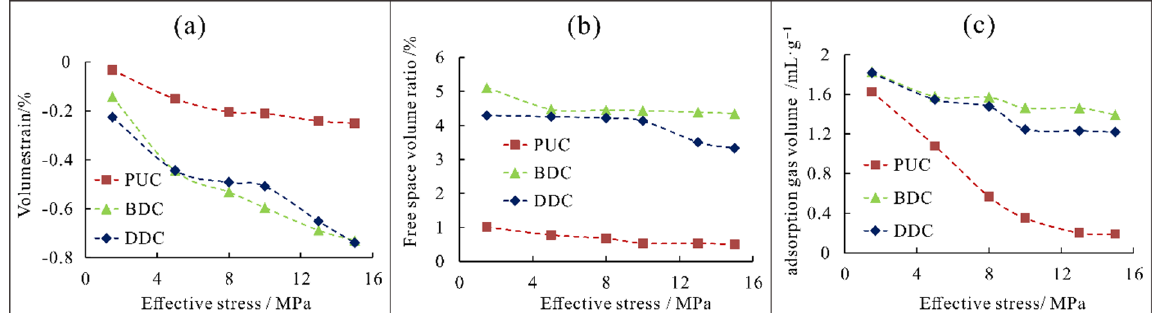
Figure 6. Changes in coal matrix strains, free space volume and adsorption gas volume under effective stresses: ( a ) is the volumes train of coal matrix; ( b ) is the free space volume of coal core; ( c ) is the adsorption gas volumes of coal samples.